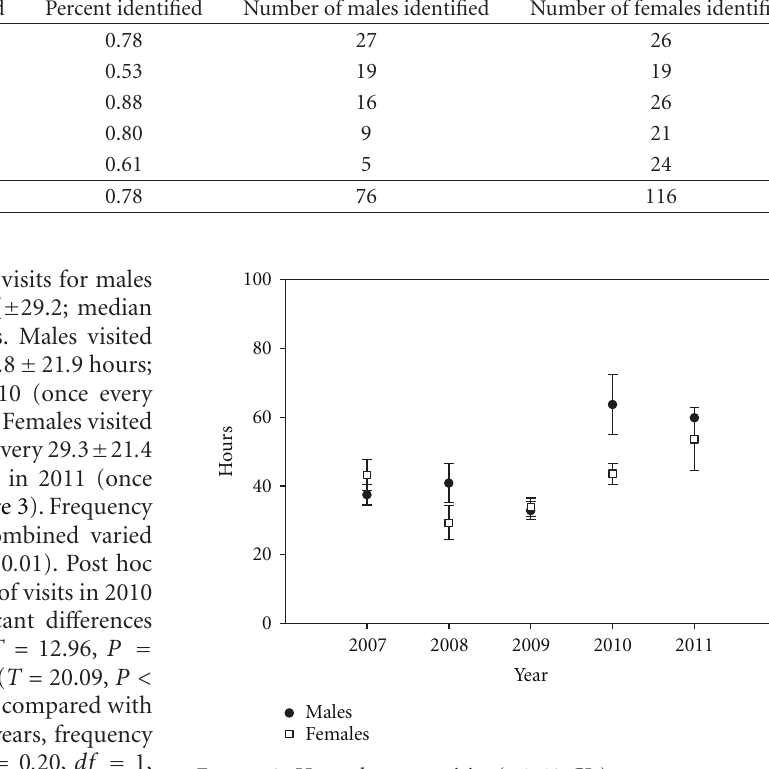
Figure 3: Hours between visits ( ± 95% CIs) to water sources by male and female mule deer during summer (July and August) in western Utah, USA, 2007–2011. The confidence interval is missing for males in 2011, because there were too few visits to water by males in that year to generate a meaningful interval.